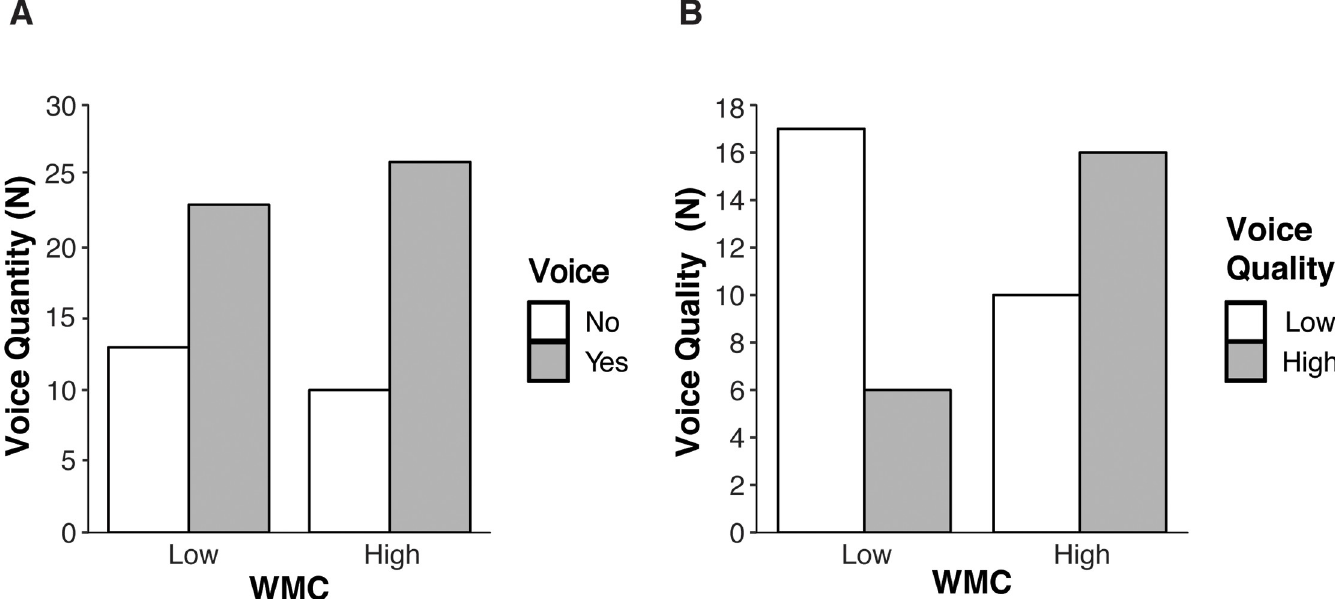
Fig 1. Study 1 –Voice quantity and quality for (low/high) WMC groups. A. Voice Quantity (N participants who voiced / did not voice) by WMC groups (High/Low). B. Voice Quality (N participants who voiced high / low voice quality) by WMC groups (High/Low).